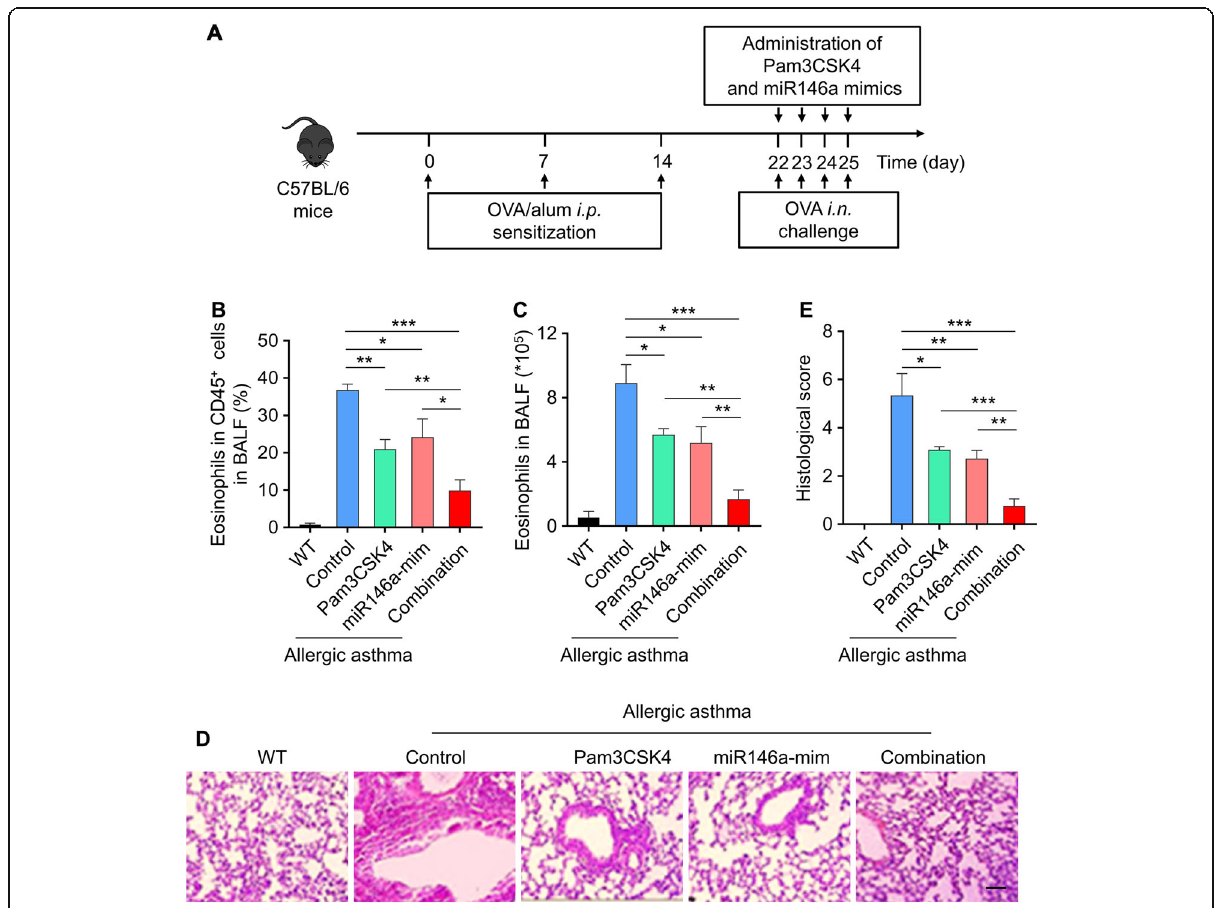
Fig. 4 Simultaneous administration of TLR2 agonist and miR146a mimics efficiently protect mice against OVA-induced allergic asthma. a Schematic diagram of the experimental protocol. The doses of Pam3CSK4 and miR146a mimics were 0.1mg/kg and 1mg/kg, respectively. b Eosinophils in CD45+ cells in BALF. c Eosinophils in BALF. d Histologic sections of lungs from each group were analyzed by H&E. Pictures show representative samples of 6 mice/group. Scale bar=100 μ m. e Histological scores for assessment of lung injury were shown. Data represent means ± SD. WT, wide type mice without OVA-induced allergic asthma. n =6, * p <0.05, ** p <0.005, *** p